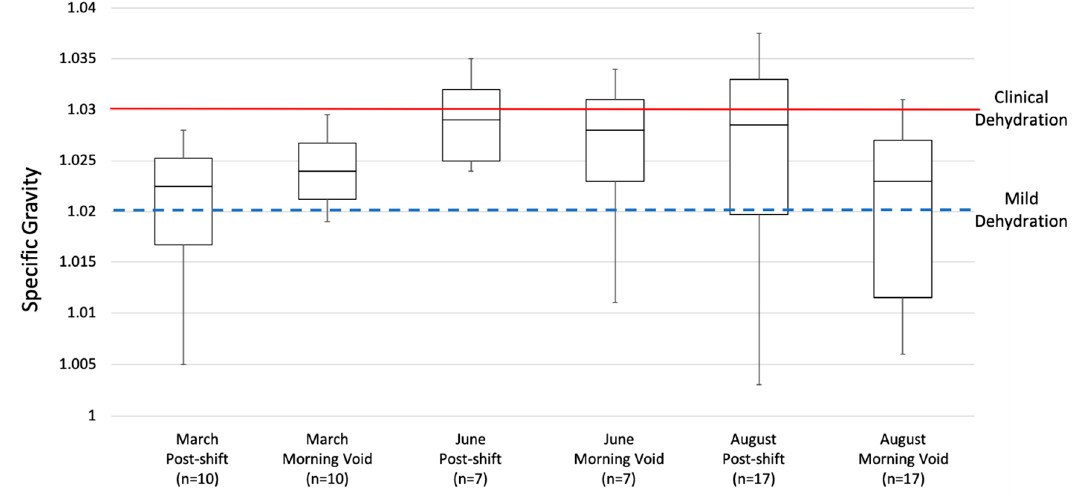
Figure 2. Comparison of specific gravity quartiles by month and collection time ( n = 28).